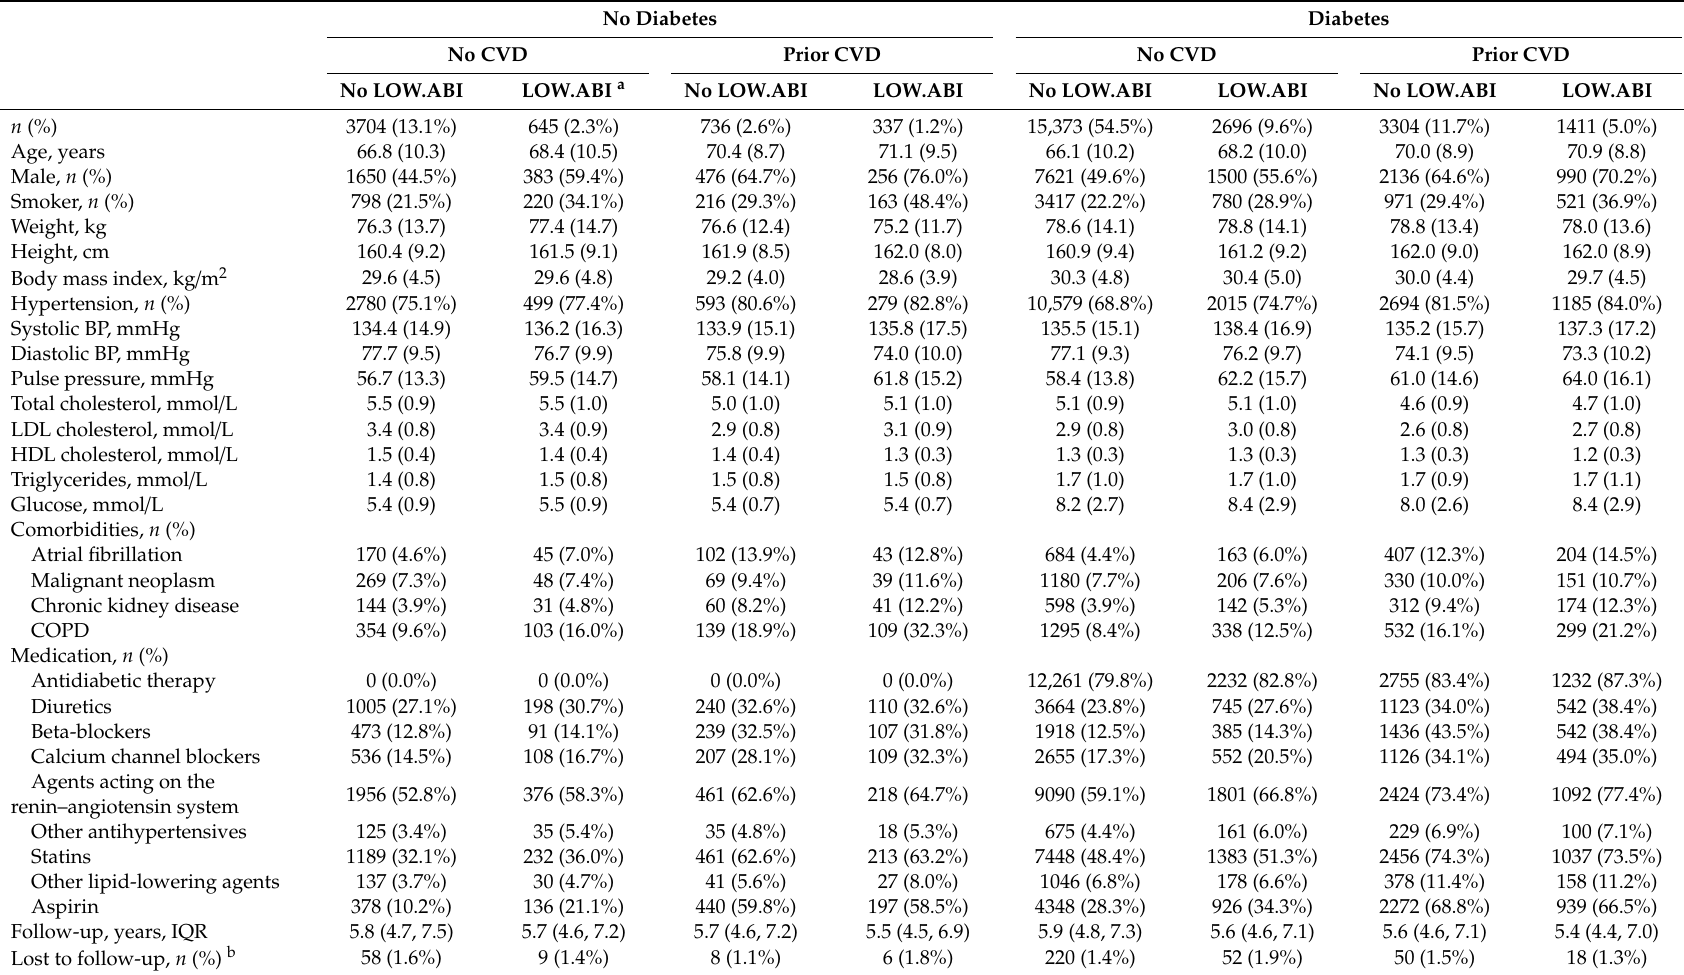
Table A5. Baseline characteristics of the study population according to diabetes, prior CVD, and ankle–brachial index. Complete